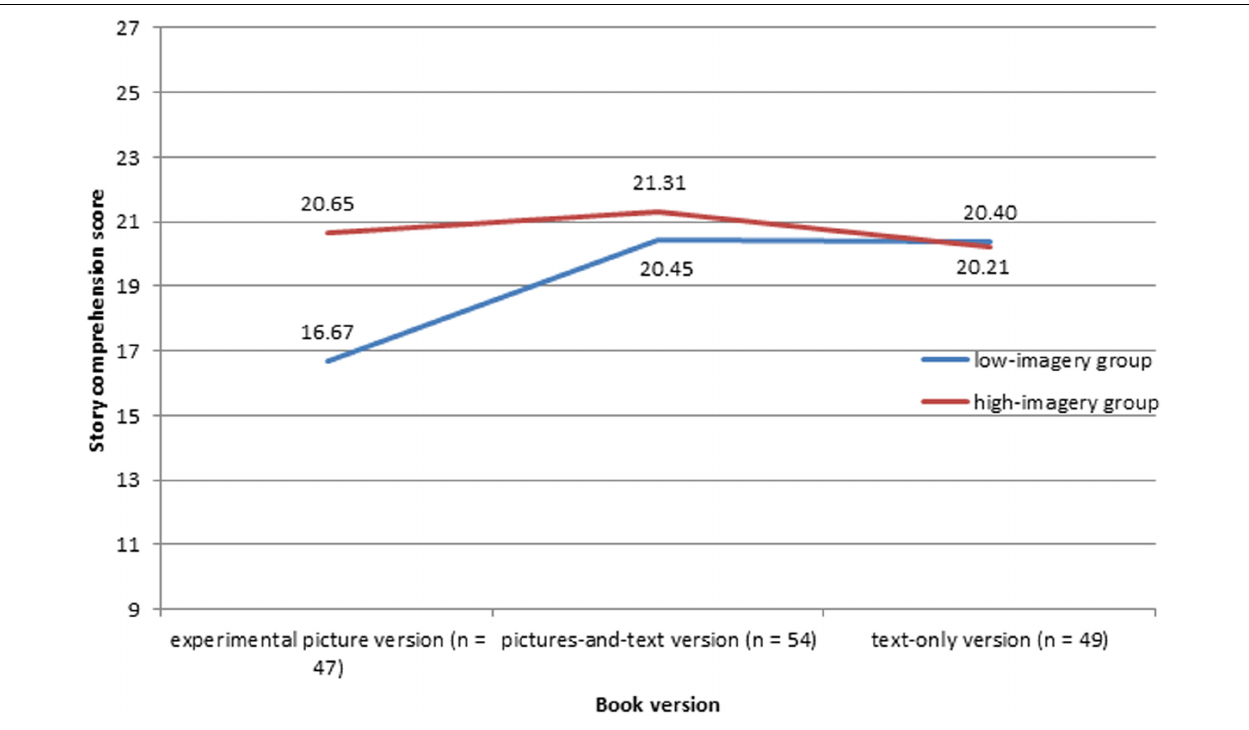
FIGURE 1 | Interaction between imagery skills and test condition, controlling for oral reading fluency and